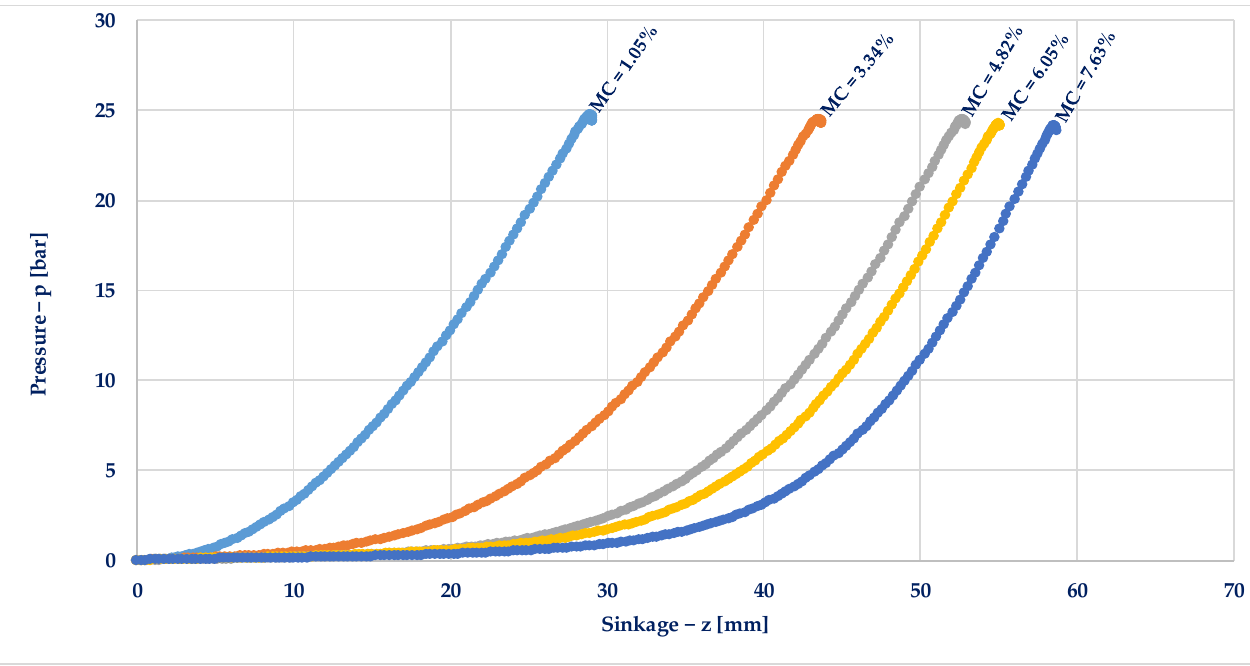
Figure 4. Sandy loam pressure–sinkage relationship at different moisture contents.